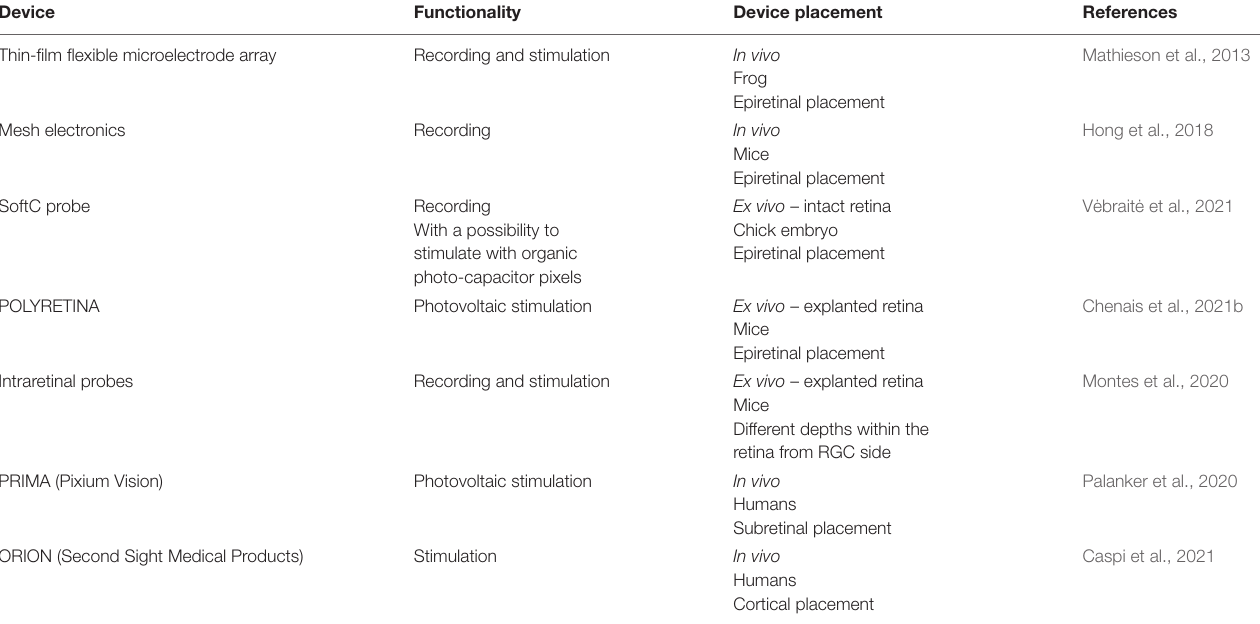
TABLE 1 | Summary of retinal prosthesis